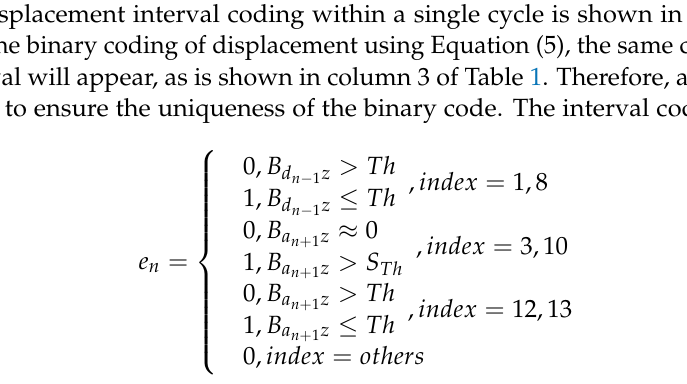
Figure 6. The waveform of the magnetic flux density of the coded Hall array.